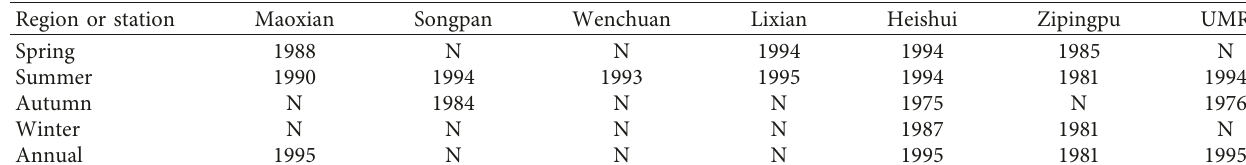
Figure 6: Box diagram of Z at 6 stations in UMR for 1960–2015. Table 4: Abrupt change points of precipitation time